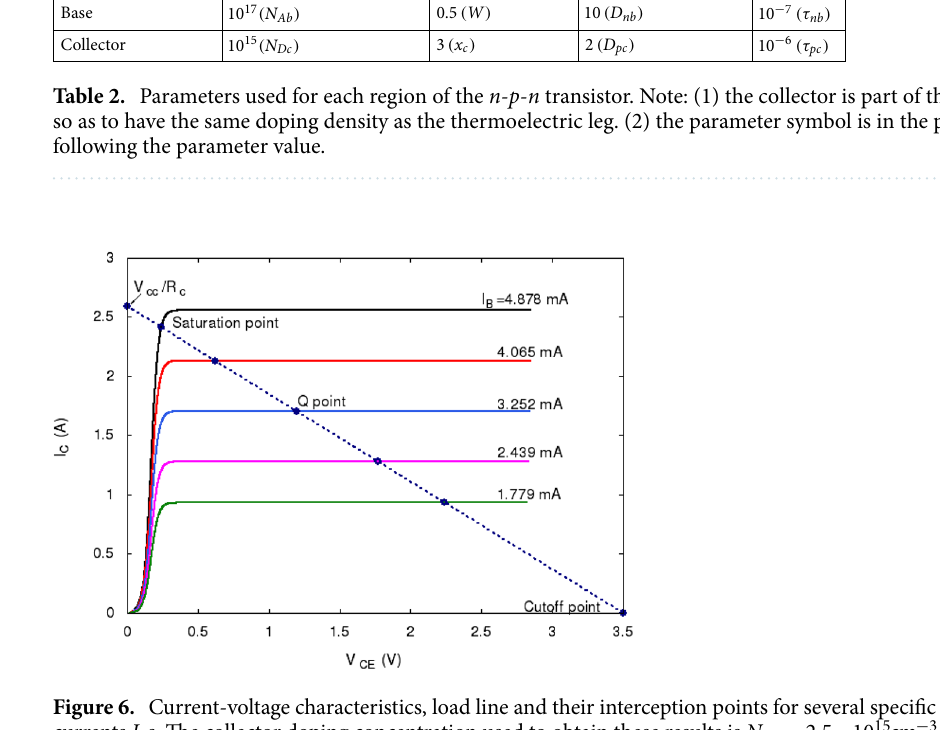
3 15 cm − . The rest